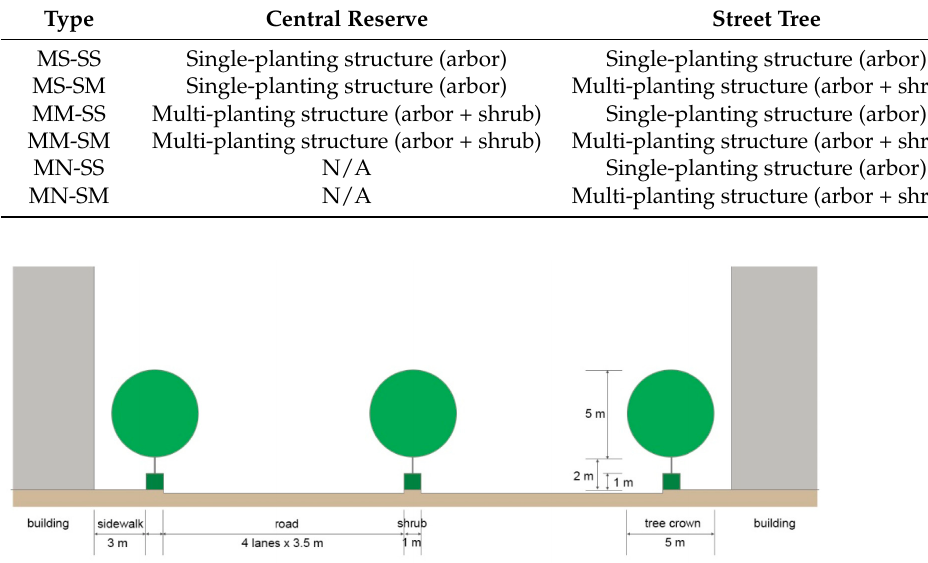
Table 1. Details of the six models compared in this study.